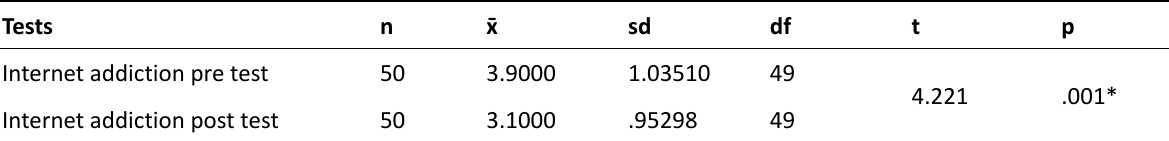
Table 4. Evaluation of the internet usage time pre and post participation of regular